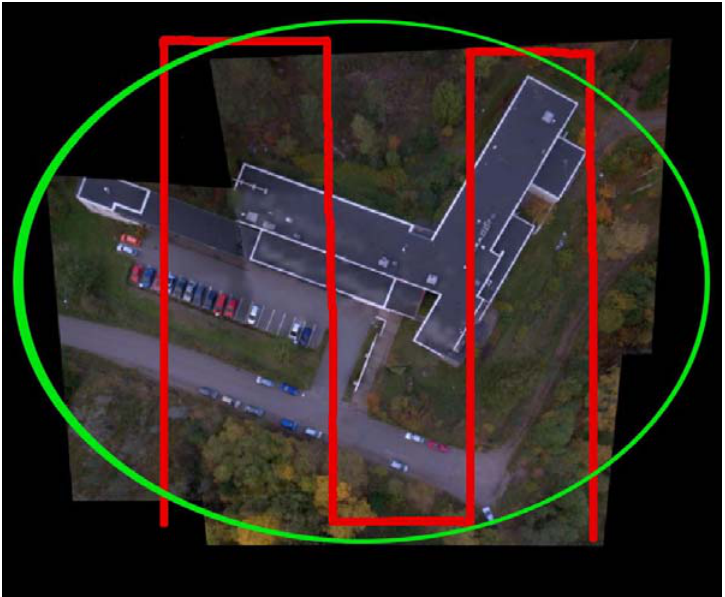
Figure 3. Flight routes in the Masala mission. The regular block with vertical images is in red and the rotating image flight with oblique images aimed at the building is in